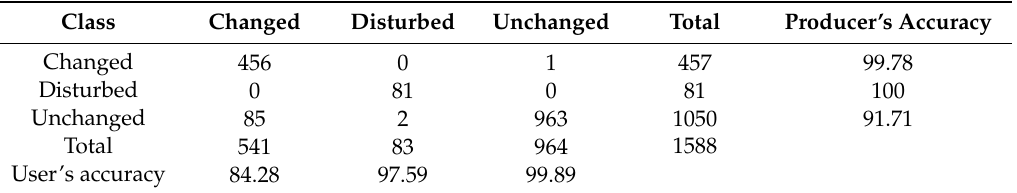
Table 3. Accuracy assessment of land cover change classification.